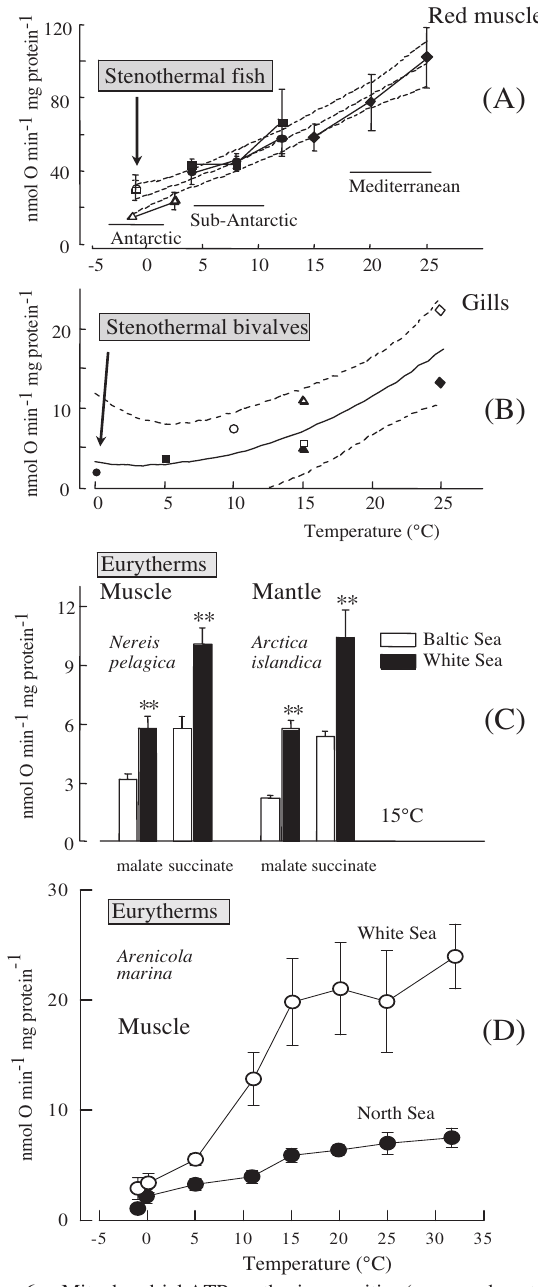
F IG . 6. – Mitochondrial ATP synthesis capacities (measured as state 3 respiration rates) in stenothermal and eurythermal ectotherms (adopted from Pörtner et al ., 2000; Pörtner, 2004). (A) State 3 res- piration rates at various temperatures of isolated mitochondria from red musculature of Antarctic (open symbols), Subantarctic (South American, filled circles and squares) and Mediterranean fish species (filled diamon, redrawn from Johnston et al. , 1998). (B) State 3 respiration rates of mitochondria isolated from temperate and Antarctic bivalves and studied at various temperatures empha- size the down regulation of ATP synthesis capacities, similar to fish. (C) Elevated ATP synthesis capacities in mitochondria from White Sea compared to Baltic Sea populations of Nereis pelagica and Arctica islandica and from White Sea and North Sea popula- tions of Arenicola marina (D) correlate with elevated proton leak- age rates (Tschischka et al. , 2000; Sommer and Pörtner, 2004). Similar patterns were observed in a comparison of northeastern Arctic (Barents Sea) and North Sea cod ( Gadus morhua ) populations (T. Fischer, R. Knust, H.O. Pörtner,